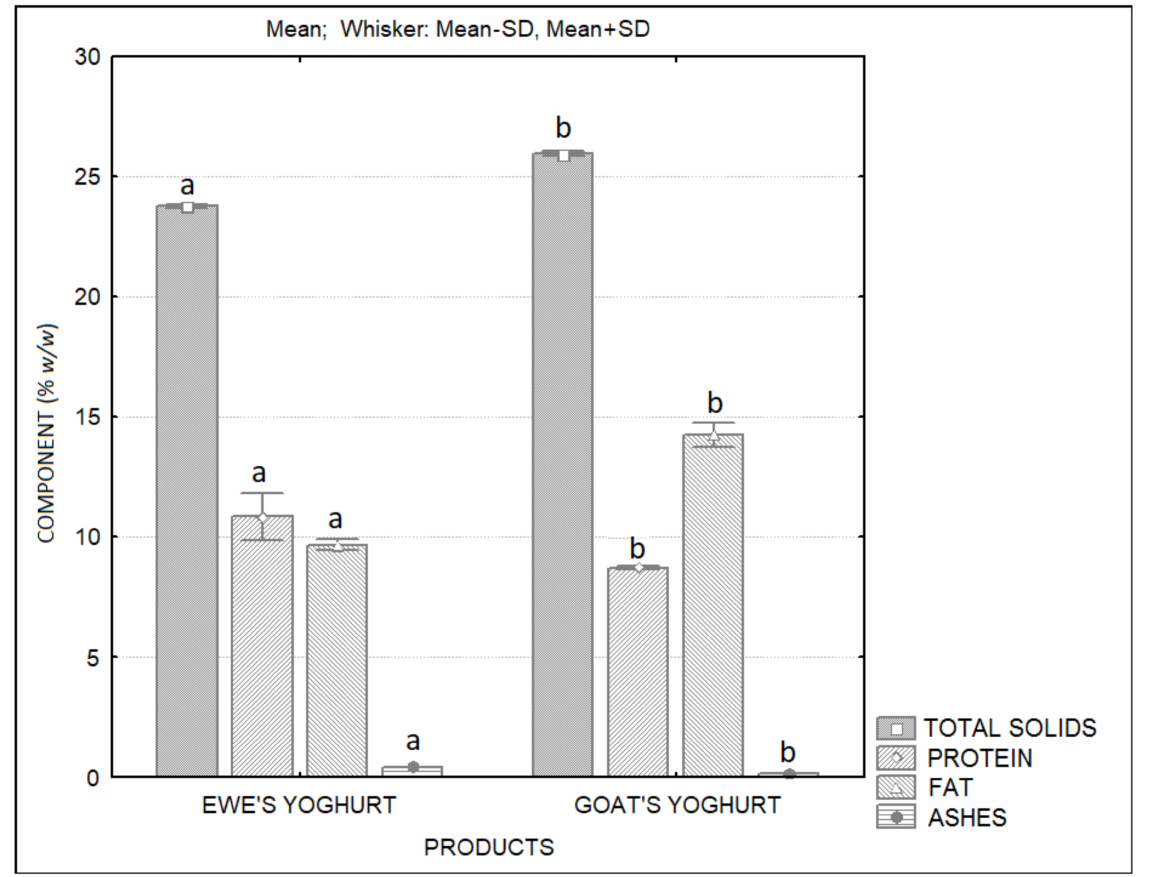
Figure 1. Gross composition of ewe’s and goat’s yoghurts produced with UF concentrated cheese whey. Different letters indicate significant differences ( p < 0.05) between components of ewe’s and goat’s yoghurts.